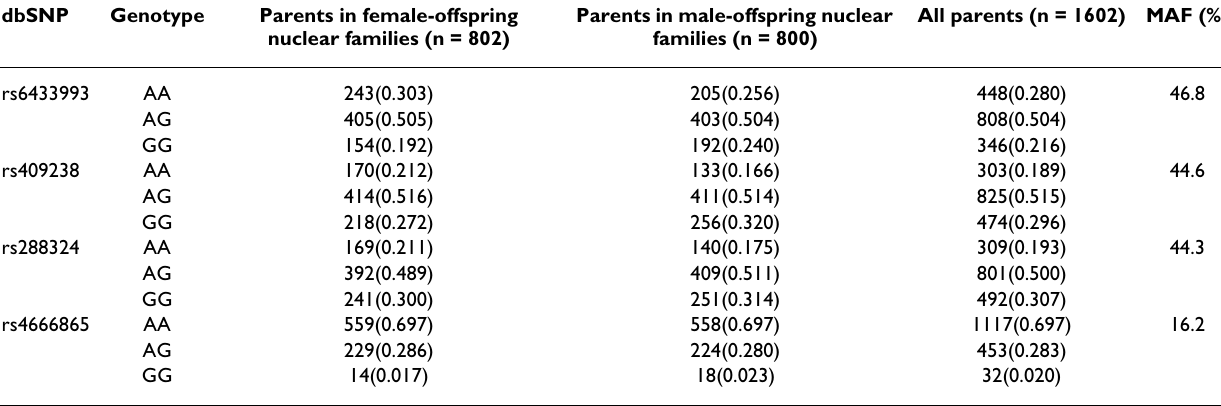
Table 3: Frequencies of selected FRZB polymorphism in the Chinese population dbSNP